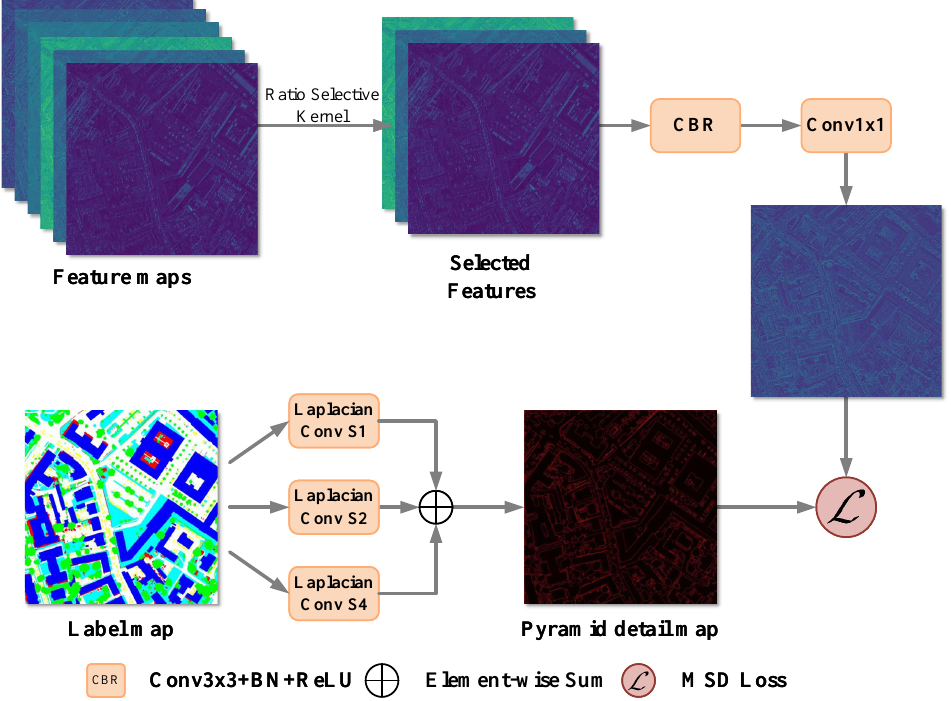
Figure 4. Schematic diagram of the MSD loss calculation process. Stridds 1, 2, and 4 in the Laplace convolution operator are denoted as S1, S2 and